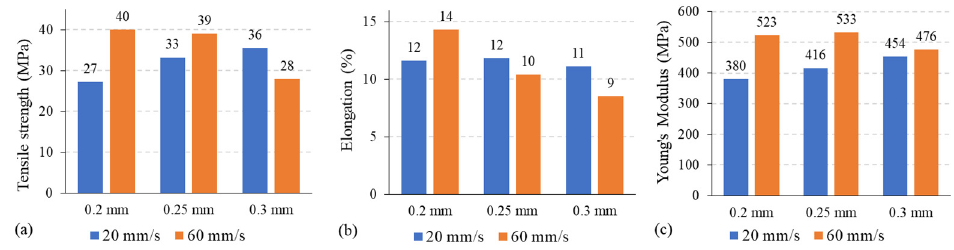
Figure 13. PEEK ( a ) strength, ( b ) elongation at break, ( c ) Young’s modulus and sensitivity to various layer thicknesses with different printing speeds (in mm/s).